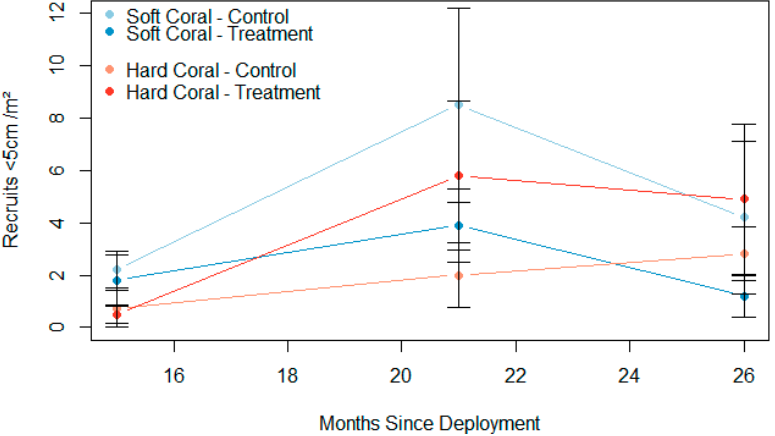
Figure 12. Mean number of hard and soft coral recruits observed on Coral Greenhouse. Error bars show standard error of means. No statistically significant difference between control and treatment or hard and soft coral across time.